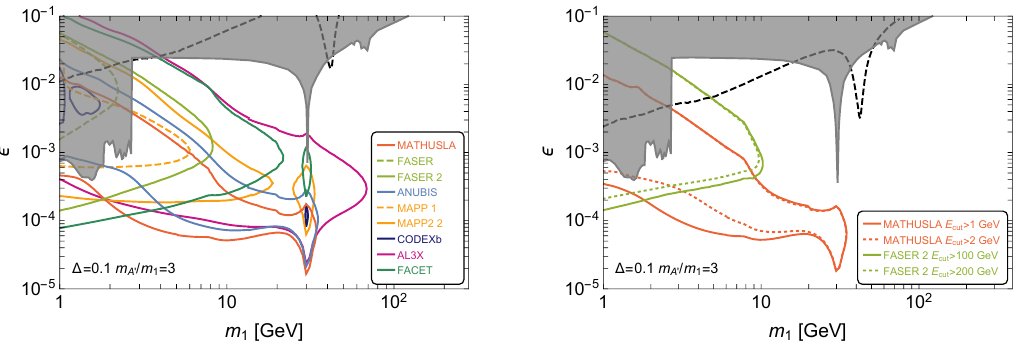
Figure 2 . Left panel: the same as figure 1 but for the case of the scalar iDM model described in section 2.2. For illustration, we only show the case of the first benchmark considered ( ∆ = 0 . 1 , m A 0 /m 1 = 3 ) as the results between the scalar and fermionic cases do not differ drastically for most of the experiments. Right panel: projected sensitivities of MATHUSLA and FASER 2 for the fermionic iDM model and for two choices of the energy threshold E cut . figure 2. The shaded grey region depicts the current experimental constraints on the invisible dark photon already mentioned in section 2, coming from BaBar [35] and LEP [30]. Since in the region m ∼ m the Z boson coupling to the dark states is not suppressed, Z A 0 we also include the bound coming from the Z invisible decay [36]. The colored contours, on the other hand, show the projected future sensitivities of the experiments listed in section 3.2. Finally, along the dashed black line the D abundance matches the observed 1 one. Figure 1 and figure 2 correspond to the fermionic iDM (see section 2.1) and scalar iDM (see section 2.2) models,